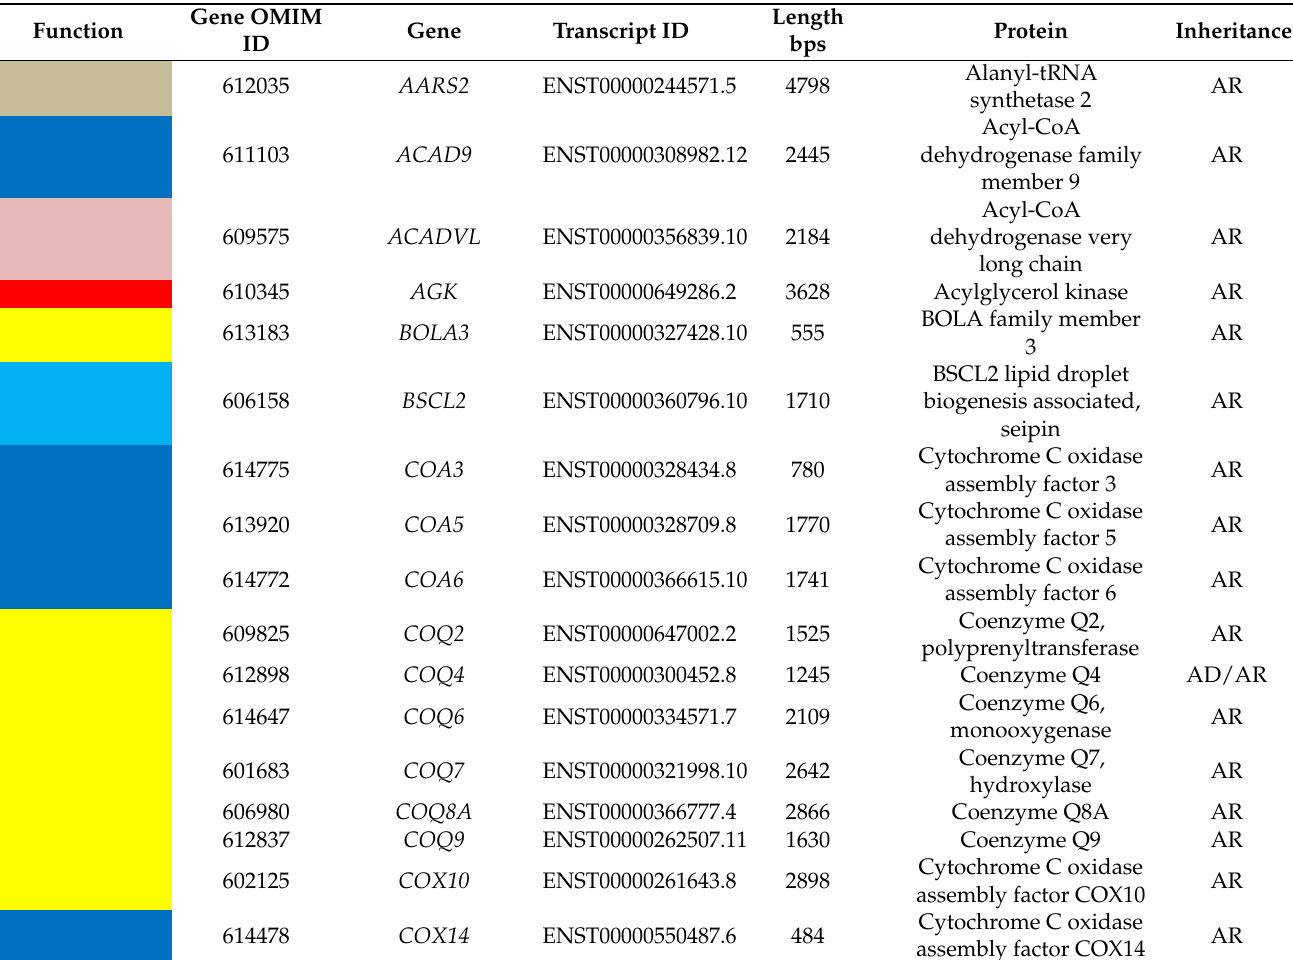
Table 3. List of major mitochondrial and nuclear (mtDNA and nDNA) genes collected through literature and database research over the past ten years in association with mitochondrial heart